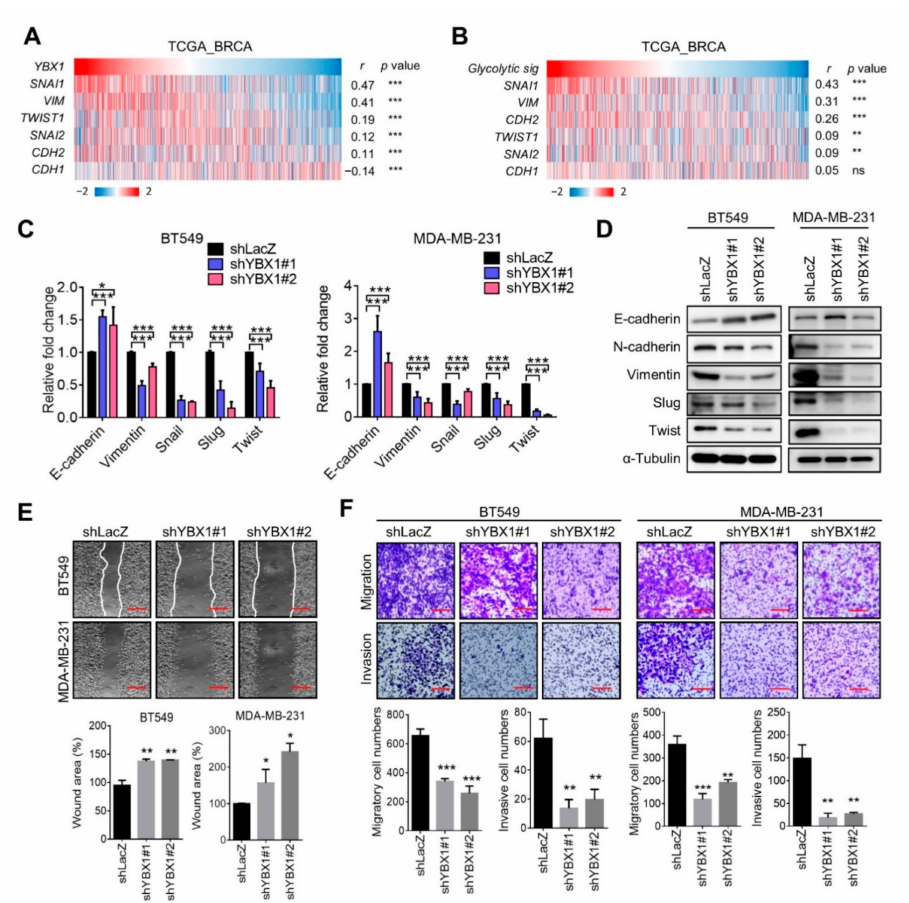
Figure 6. YBX1 promotes epithelial-to-mesenchymal transition gene expressions and invasiveness of triple-negative breast cancer cells. ( A ) Heat map plot showing correlations between YBX1 and EMT-related genes in TCGA_BRCA dataset. ( B ) Heat map plot showing correlations between the glycolysis signature and EMT-related genes in TCGA_BRCA dataset. ns, not significant. ( C ) RT-qPCR analyses of EMT-related gene expressions in YBX1-knockdown BT549 and MDA-MB-231 cells. ( D ) EMT-related protein levels in YBX1-knockdown BT549 and MDA-MB-231 cells. ( E ) Wound-healing assay of cell migration using YBX1-knockdown BT549 and MDA-MB-231 cells. Wound area was quantified and expressed as percentage relative to the control group. Scale bar = 100 µ m. ( F ) Transwell analyses of migration and invasion with YBX1-knockdown MDA-MB-231 and BT549 cells. Representative images from randomly selected fields of the transwell insert are shown. Scale bar = 100 µ m. Error bars indicate the mean ± SD of at least three independent replicates. * p < 0.05; ** p < 0.01; *** p < 0.001, as determined by unpaired t